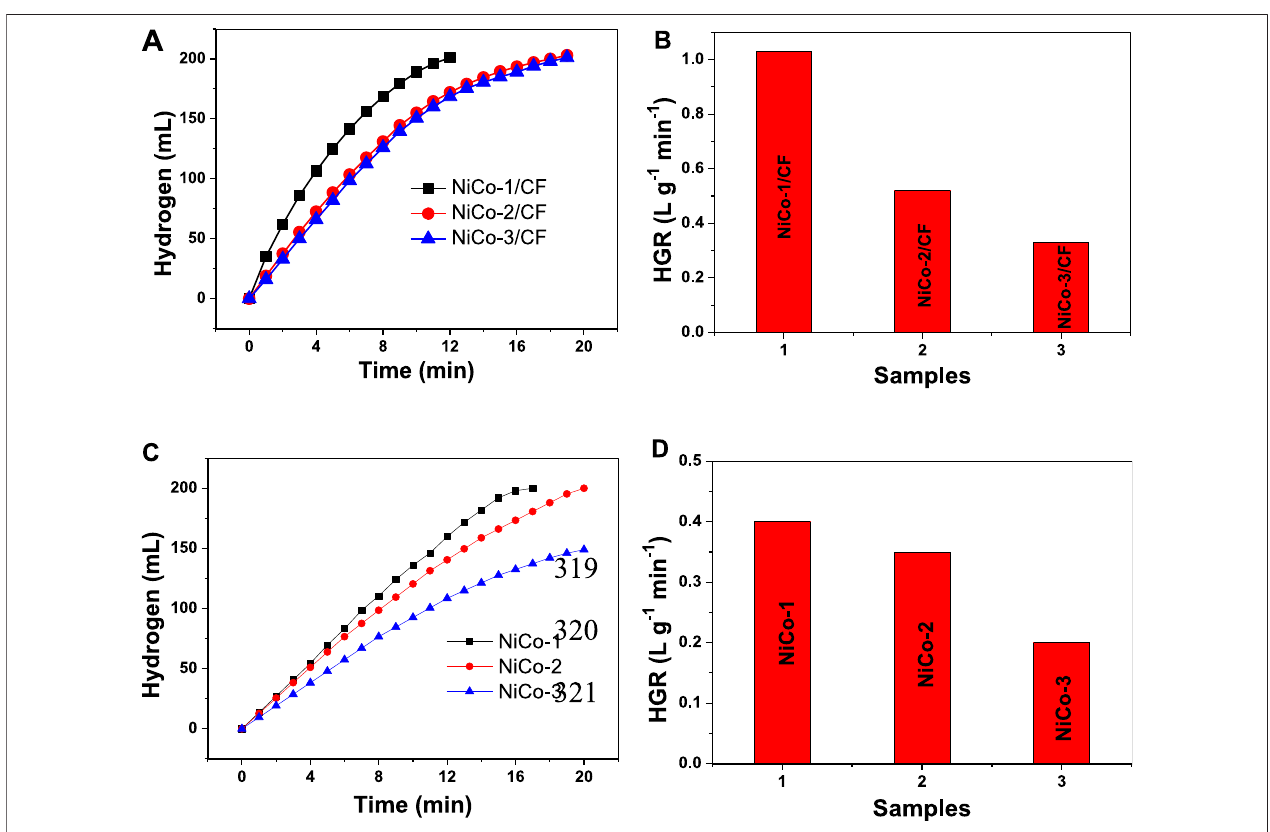
FIGURE 4 | Hydrogen evolution (A,C) and corresponding HGR values (B,D) for CF-supported NiCo samples and unsupported NiCo samples.